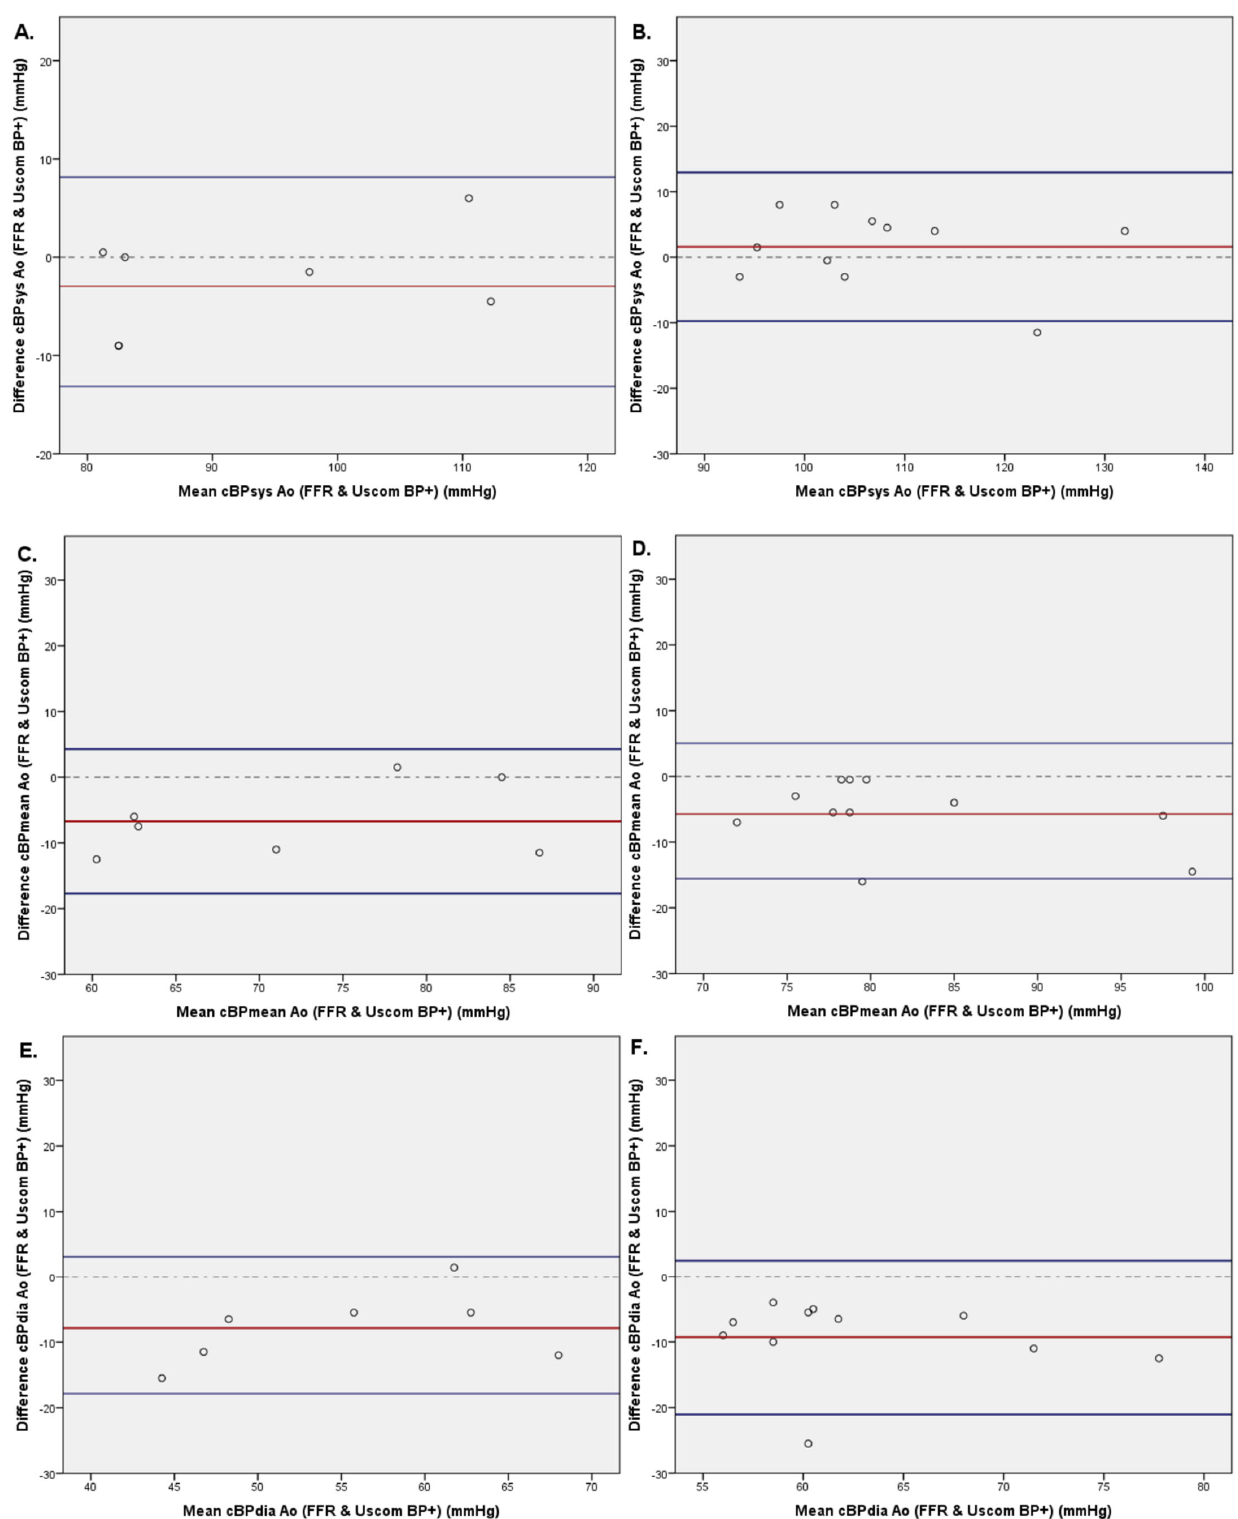
Figure 12. Bland–Altmann plots of systolic ( A , B ), mean ( C , D ), and diastolic ( E , F ) central blood pressure comparing non ‐ invasive blood pressure (Uscom BP+ device) to invasive central blood pressure measured with FFR wire separation on patients with ≤ 2 cardiovascular risk factors (CVRF) ( A , C , E ) or ≥ 3 CVRF ( B , D , F ).